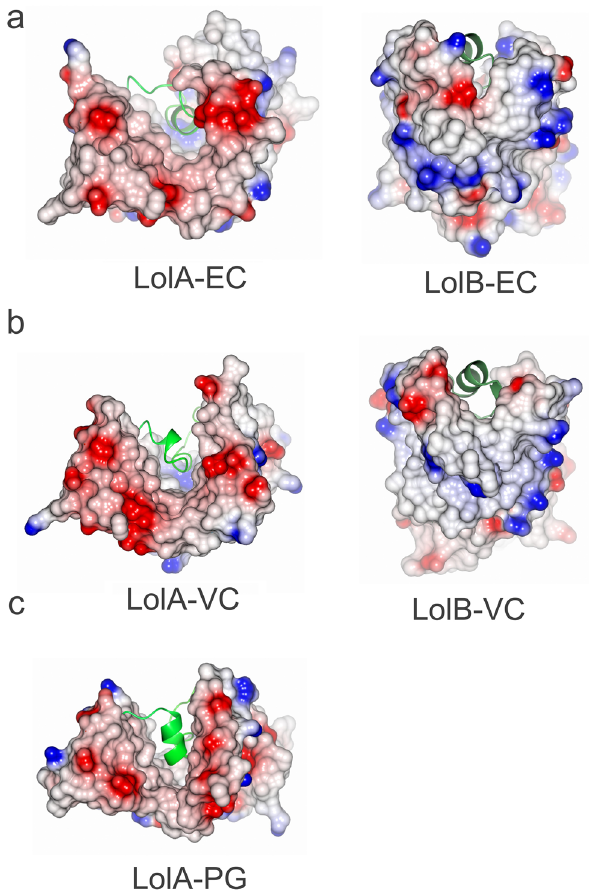
Figure 4. Electrostatic representation of the opening of the hydrophobic cavity of LolA and LolB from different bacteria. ( a ) The hydrophobic cavity of LolA-EC is lined with negatively charged residues. The cavity of LolB-EC is on the other hand predominantly lined with positively charged residues. ( b ) LolA-VC and LolB-VC have similar surface charge distribution. ( c ) The hydrophobic cavity of LolA-PG is similarly lined with negatively charged residues. For clarity the helices filling the cavities are depicted as ribbons in green.